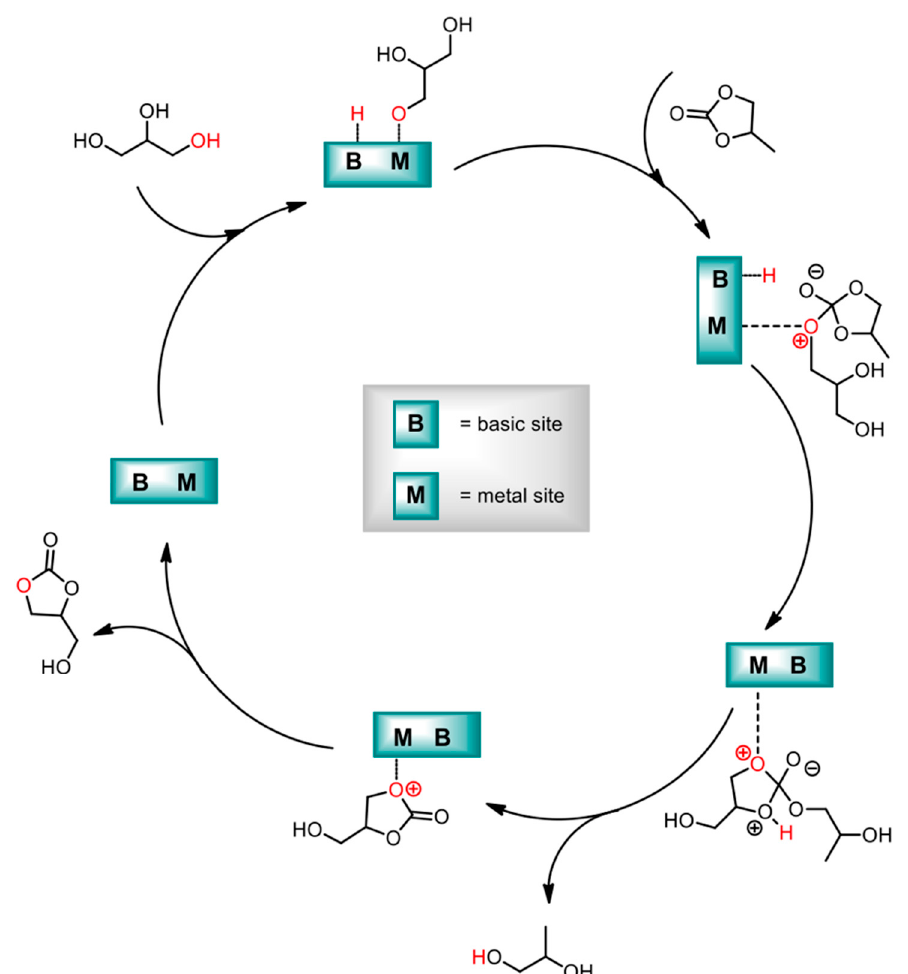
Figure 6. Mechanism of solid-base-catalyzed transesterification of glycerol. Adapted from Ref. [112]. Copyright 2017 American Chemical Society.